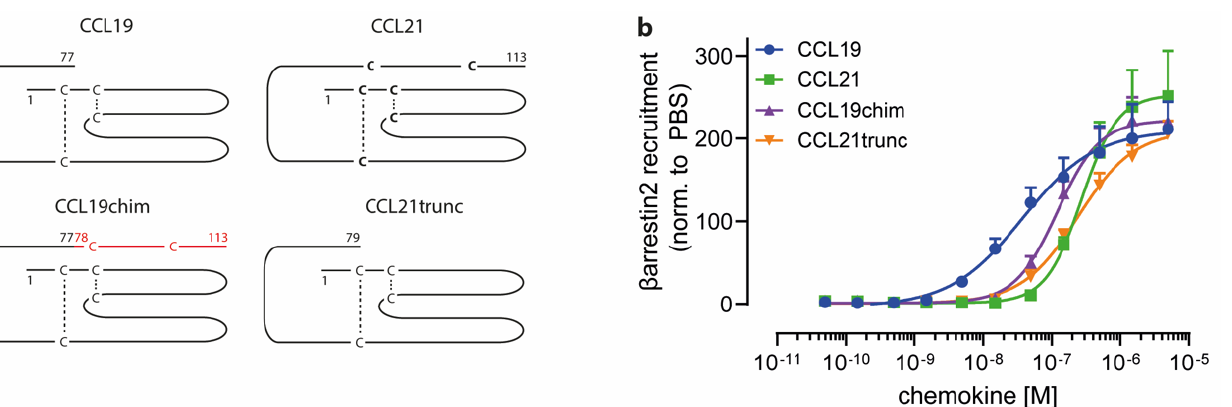
Figure 1. Ligand-biased CCR7 signaling only partially relies on the C terminal tail of CCL21. ( a ) Schematic representation of native CCL19 and CCL21, the naturally occurring C-terminally trun- cated chemokine variant CCL21trunc and CCL19chim, a CCL19 variant extended by the CCL21 ′ s C terminus (marked in red). Characteristic disulfide bonds (dashed lines) between cysteine (C) resi- dues and the specific chemokine length indicated by the number of the last amino acid are depicted. ( b ) β arrestin2-NLuc158 recruitment to CCR7-NLuc11 upon chemokine stimulation with graded concentrations of each chemokine variant. The area under the curve (AUC) analysis for each chem- okine representing the mean ± SD of n = 3 is shown. ( c ) LgBit-MiniG α i is recruited to CCR7-NLuc11 in a concentration-dependent manner for all tested chemokine variants. Normalized mean AUC values ± SD of n = 3 are shown. ( d ) Calcium mobilization in 300-19 pre-B cells expressing CCR7 in response to graded concentrations of native CCL19 and CCL21. Mean AUC values ± SD of three independent experiments that were normalized to the maximal fluorescence achieved with iono- mycin are shown. ( e ) Experimental setup as in ( d ). 300-19 cells expressing CCR7 were stimulated with 50 nM of the indicated chemokine. Median AUC values from min. to max. of n = 3 are shown. Figure 2. CCL21 variants with individually mutated BBXB motifs remain functional. ( a ) Scheme of CCL21 where the three BBXB motifs are marked in red with M1, M2 and M3. ( b ) Recruitment of lgBit-MiniG α i to CCR7 upon stimulation with graded concentrations of either native CCL21 or its BBXB motif mutants. Normalized mean AUC values ± SD of n = 3 for each chemokine variant are